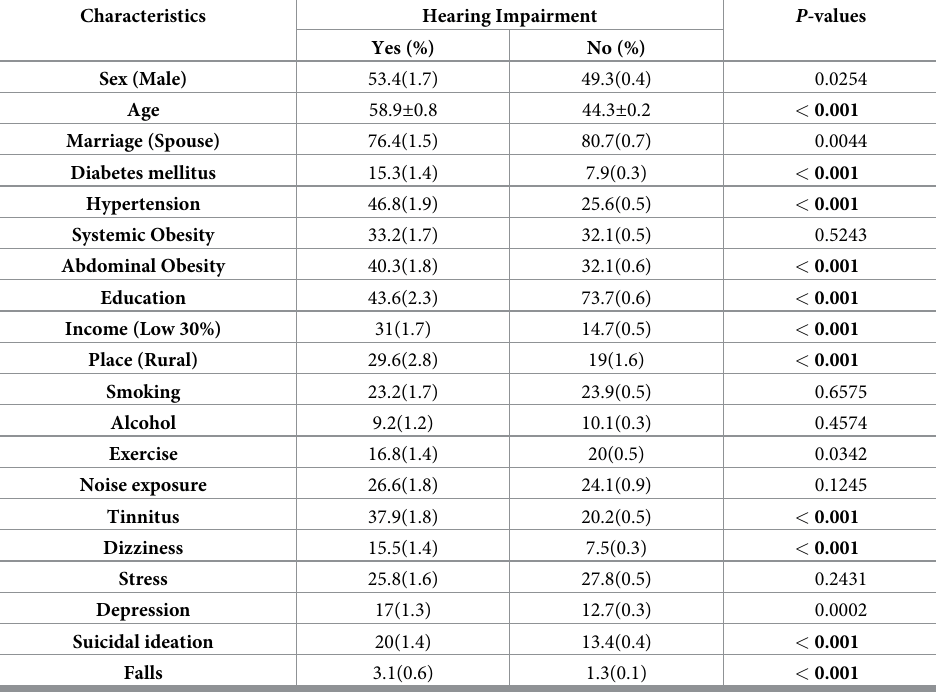
Table 1. Characteristics of the study participants (N =